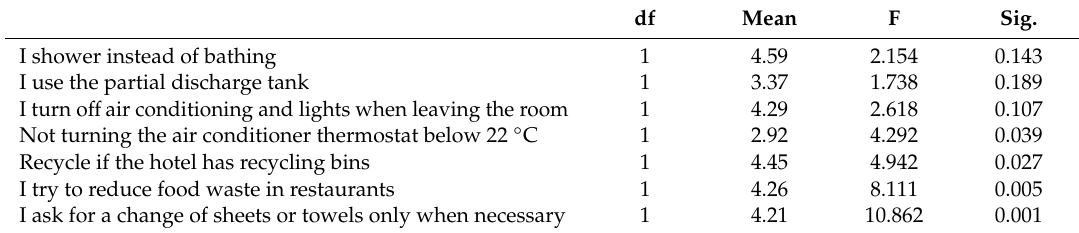
Table 12. ANOVA test comparing tourists’ circular practices in hotels by